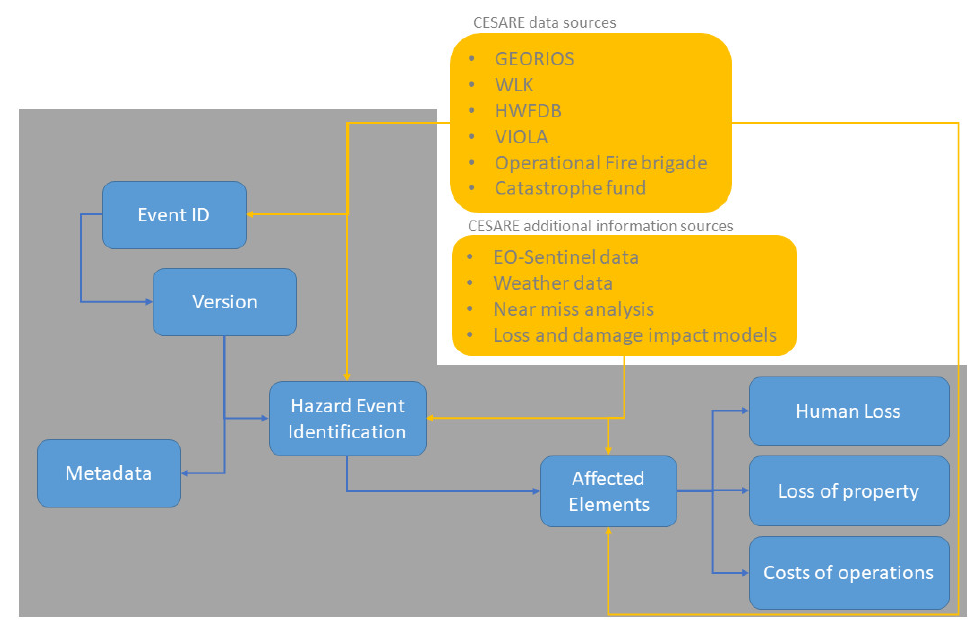
Figure 1. CESARE data model based on De Groeve et al. [20]. In yellow, CESARE specific components are